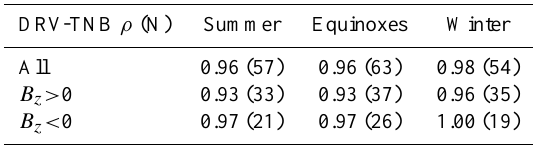
Table 3. Correlation coefficient ρ between the 24-h power at TNB and DRV, located at the same cgm latitude; the corresponding num- ber of data points N are given in